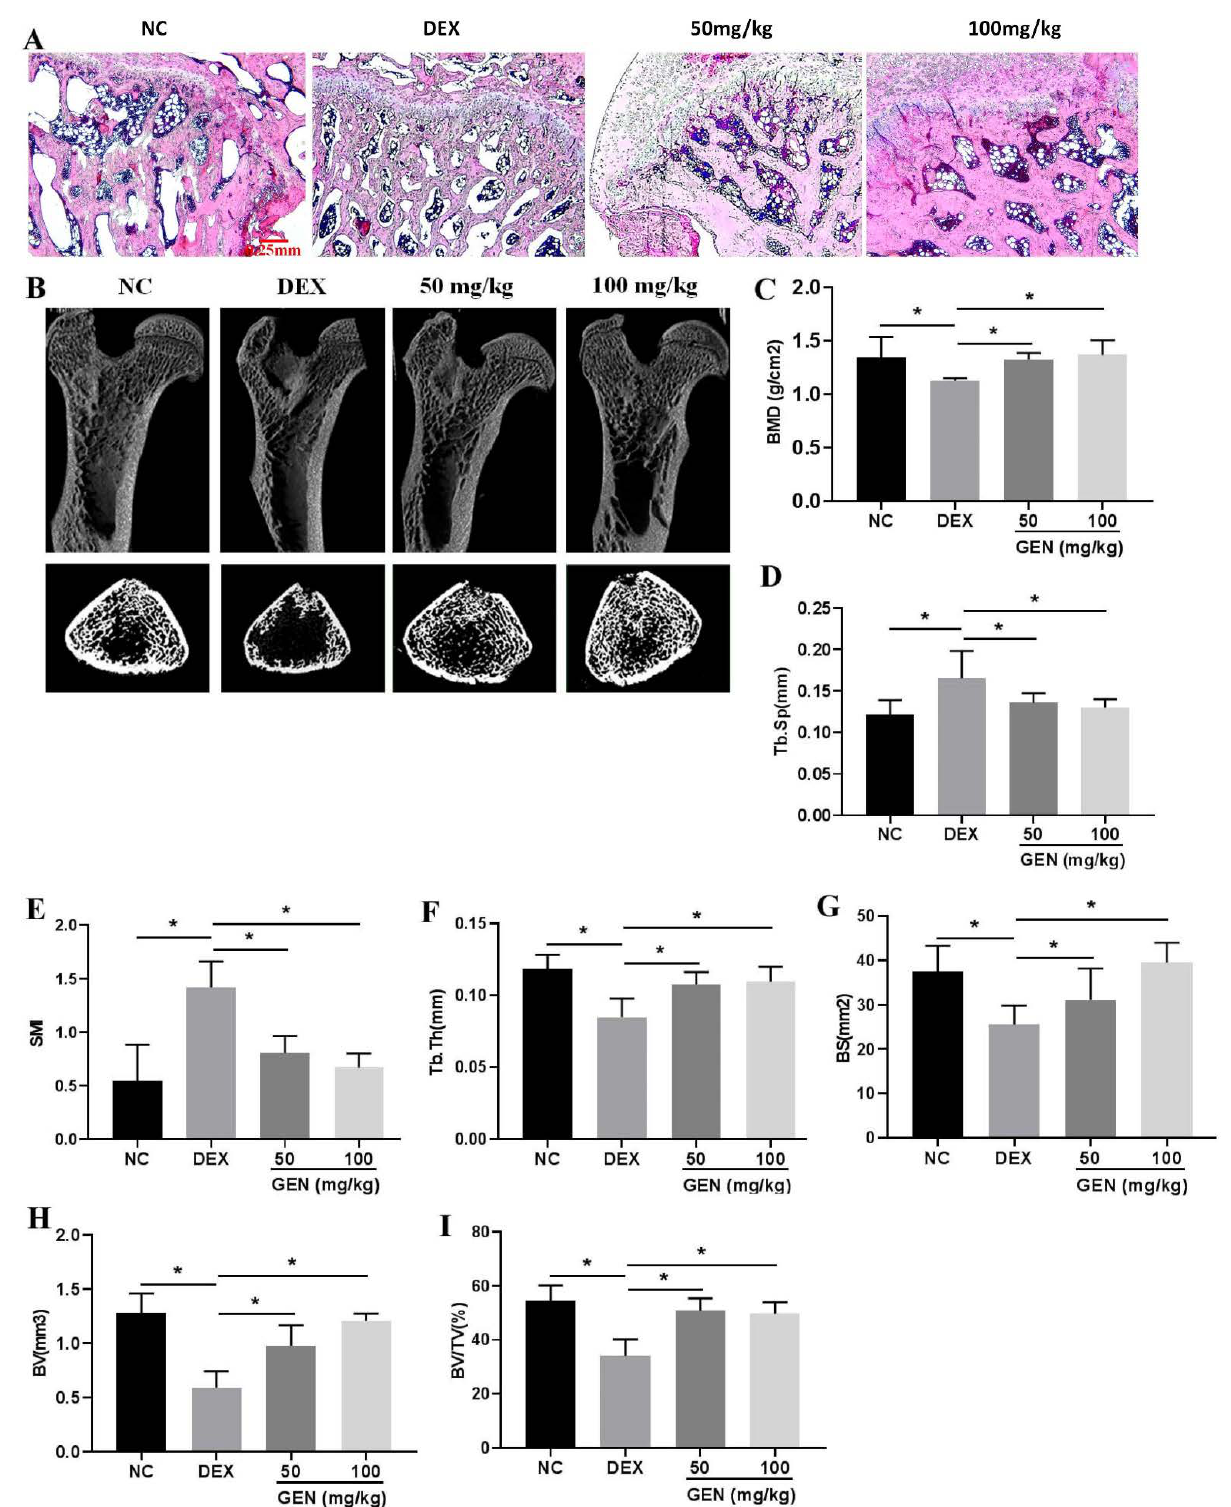
Figure 1. GEN protected against DEX-induced OP in rat models ( n = 6, repeated twice). ( A ) The HE staining of the bone trabecula on the femoral neck of the proximal femur ( × 40 magnification). ( B ) 3D reconstruction and 2D reconstruction of micro-CT on the proximal femur. ( C ) Bone mineral density (BMD) of the proximal femur. The values of Tb.Sp ( D ), SMI ( E ), Tb.Th ( F ), BS ( G ), BV ( H ), and BV/TV ( I ) were detected. All experiments were implemented separately in triplicate. * p < 0.05. NC, negative control; 50 mg/kg, Dex + 50 mg/kg GEN; 100 mg/kg, Dex + 100 mg/kg